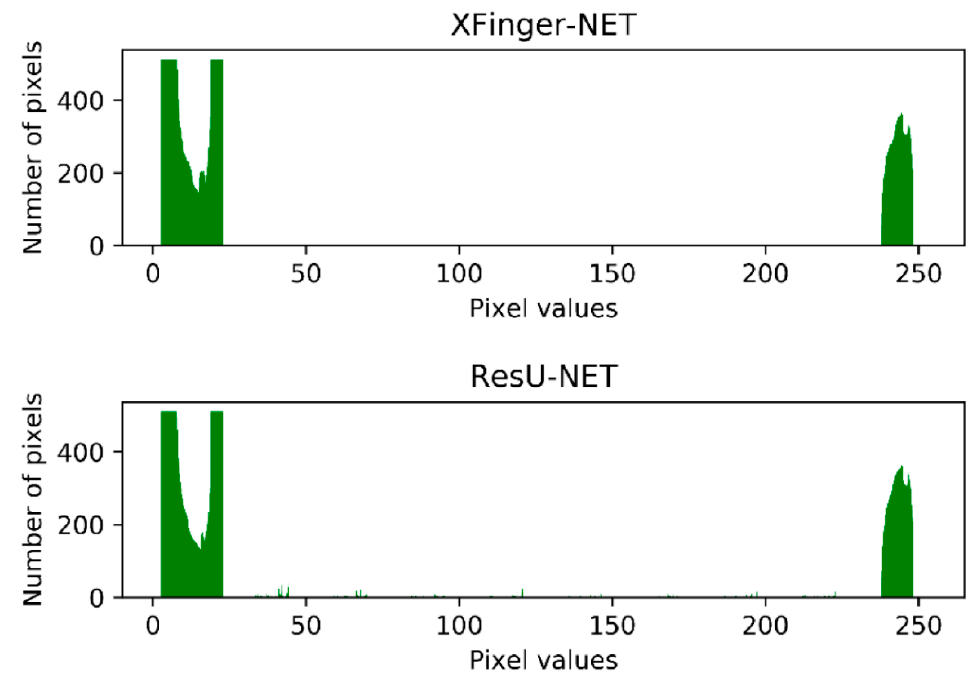
Figure 15. Histogram of the segmentation result of XFinger-Net and ResU-Net.